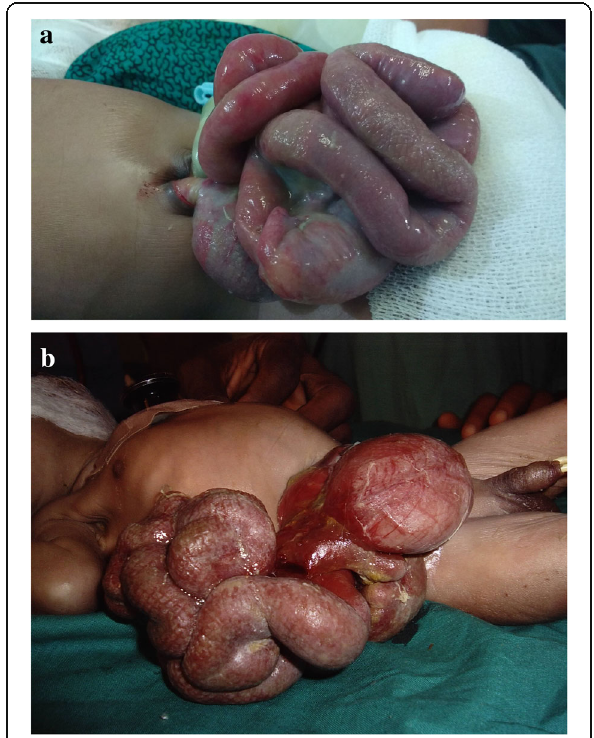
Fig. 1 a Gastroschisis seen early. b Gastroschisis seen delayed